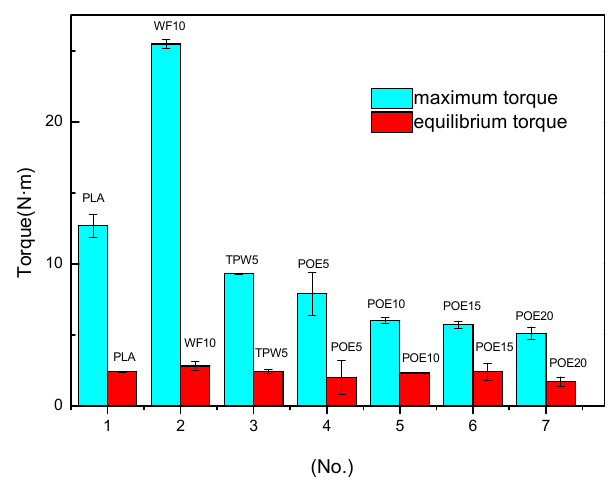
Figure 5. Maximum and equilibrium torque of different samples for 3D printing materials.